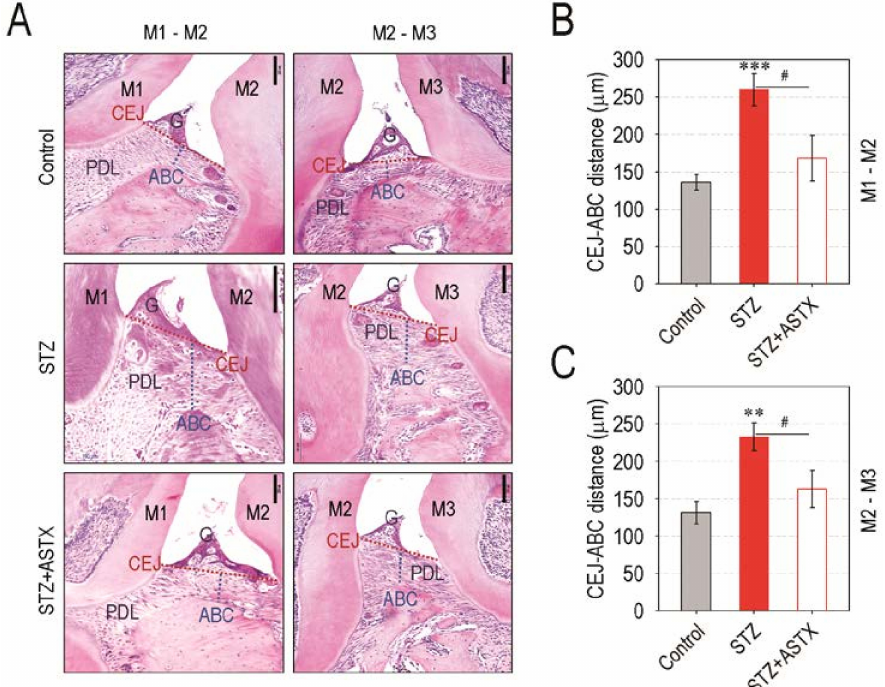
Figure 3. ASTX administration suppresses periodontal tissue degradation in STZ-induced diabetic mice. ( A ) H & E staining exhibiting hyperglycemia-triggered periodontal degradation and its suppression by supplemental ASTX in the interproximal and furcation region of maxillary molars (M1 to M3) in STZ-injected mice 60 days after hyperglycemia induction (100 × magnification). G, gingiva. Bar = 200 µ m. The distance ( µ m) between CEJ and ABC in the maxillary regions of ( B ) M1 to M2 and ( C ) M2 to M3 was calculated using ImageJ program ( n = 5). ** p < 0.01 and *** p < 0.001 vs. control group; # p < 0.05 vs. STZ